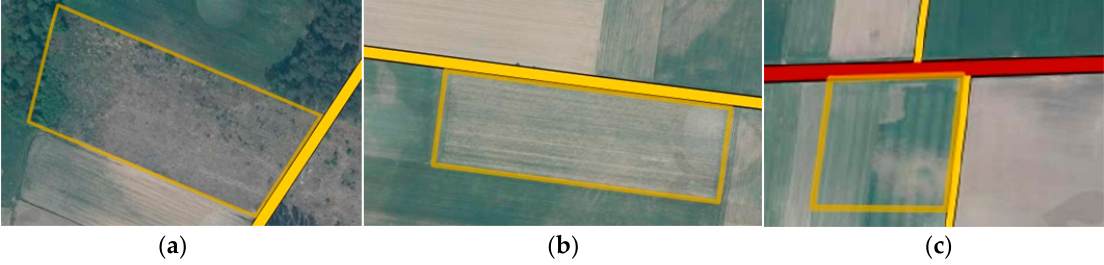
Figure 1. Selected locations: ( a ) variant 1—plot No. 175 in village Leopoldowo (V1); ( b ) variant 2—plot No. 193 in village Czartoria (v2); ( c ) variant 3—plot No. 189 in village Ł uby-Kurki (V3). (Source: